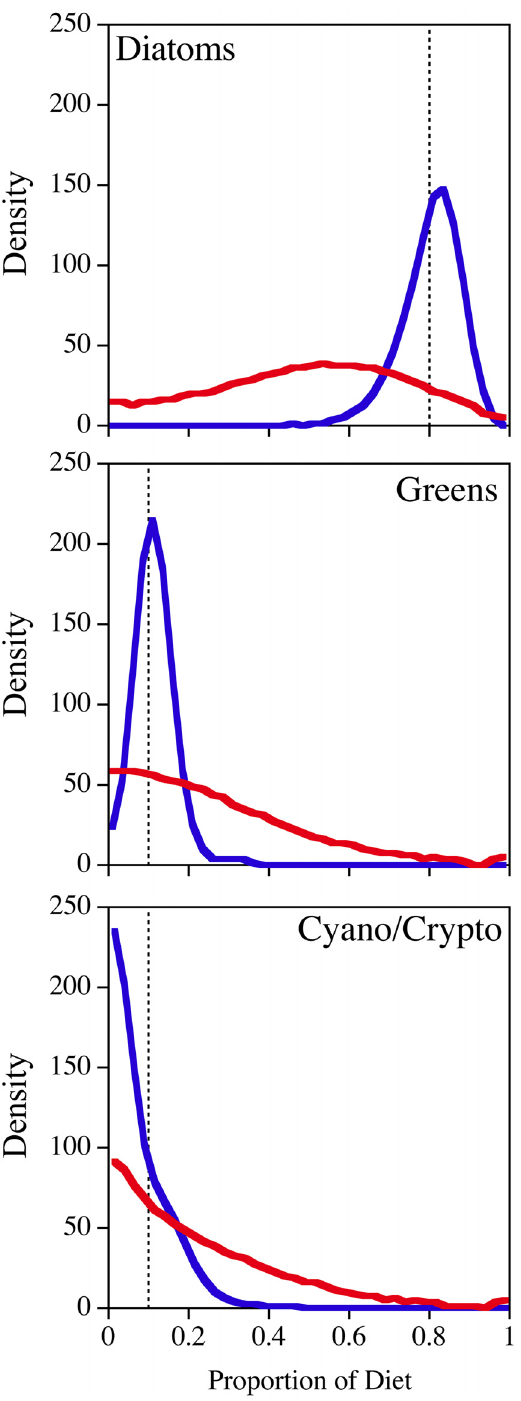
Fig 3. Results from mixed diet simulations for "pseudo- Daphnia " that were comprised of 80% diatoms, 10% green algae and 10% either cyanobacteria or cryptophytes for the SI (red) and FA (blue) based analyses. These scenarios included full uncertainty for both the resources and fractionation (n = 1000, in groups of 100). The density curves represent the posterior distributions of the 1/10 th percentiles (n = 1000) grouped into 40